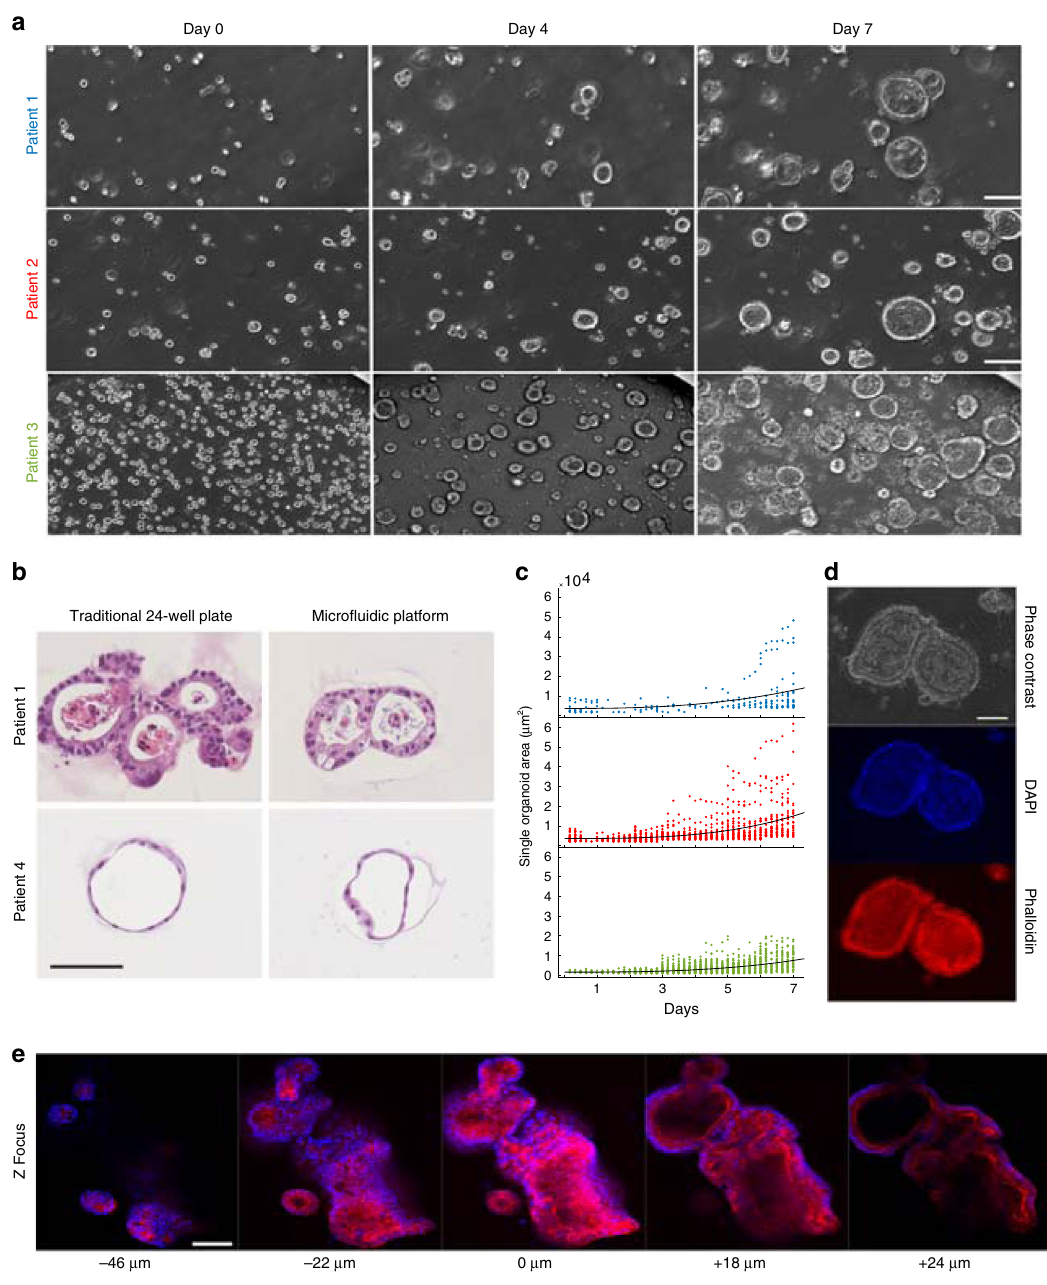
Fig. 2 Human tumor organoid culture and growth on micro fl uidic platform. a On-platform growth of organoids: three separate patient-derived pancreatic ductal adenocarcinoma (PDAC) organoids in Matrigel from single cells to formation of differentiated morphology of complex 3D structures (scale bar 100 μ m). b Organoids from two patients were grown in parallel in a traditional 24-well plate and on our micro fl uidic platform (scale bar 100 μ m). After mature organoid formation, organoids were harvested, H&E stained, and their morphologies compared and analyzed. In both platforms, organoids from patient 1 exhibited back-to-back glands with a high degree of nuclear atypia and pleomorphism with an accumulation of apoptotic luminal necrotic cells. Organoids from patient 4 demonstrated a well-differentiated morphology with simple spherical organoids and uniform nuclear and cytoplasmic features with little or no accumulation of necrotic luminal cells. c Organoid growth curves of PDAC organoid samples derived from three patients grown from single cells for 7 days on the platform. Each dot represents the cross-sectional area of an individual organoid. Patient 1 (blue), Patient 2 (red), Patient 3 (green). d Long- term culture, growth, and fl uorescent staining of fi xed PDAC organoids on the platform. Nuclei staining (DAPI) and F-actin (Phalloidin) are demonstrated (scale bar 100 μ m). e Multiple Z image slices or stacks of a group of fi xed and fl uorescently stained organoids with DAPI and phalloidin (scale bar 100 μ